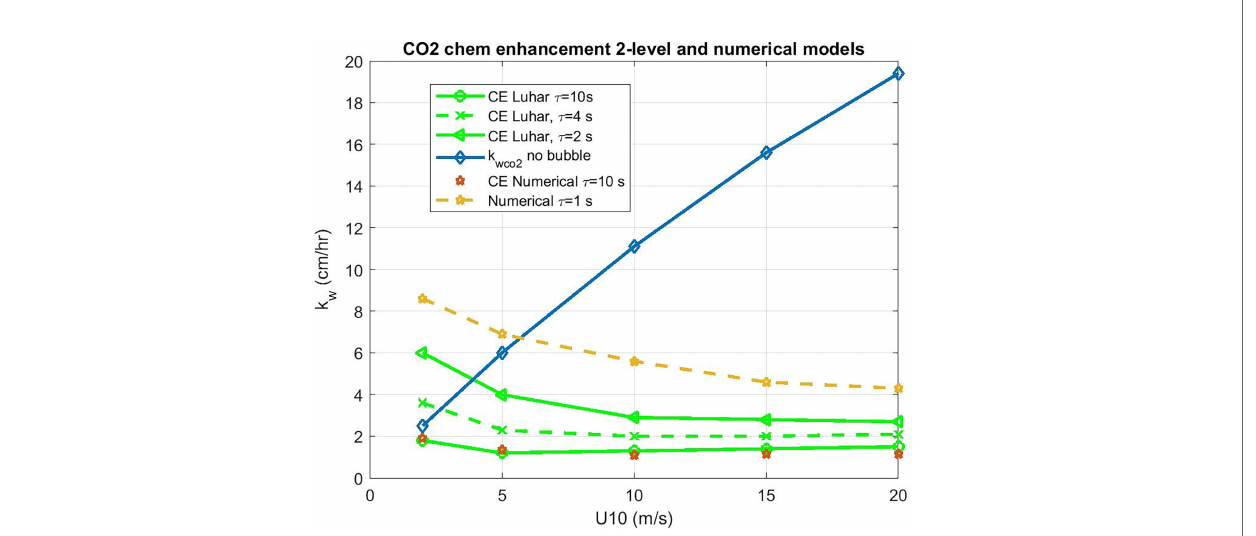
FIGURE 5 | Water side transfer velocity (normalized to Sc = 660) as a function of 10-m wind speed. The basic COAREG non-bubble relationship for neutral conditions is shown in the blue diamonds. Estimates of chemical enhancement (CE) for CO 2 are shown using a numerical model (stars) an and an analytical model (green lines) for different values of the CO 2 carbonate reaction time constant, t r.